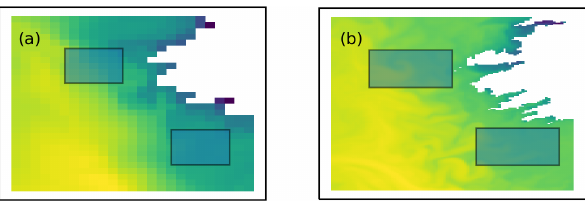
Figure 5. Similar neighbourhood sizes for a 49km neighbourhood using the approximate resolutions (7 and 1.5km) with (a) AMM7 with a 7 × 7 neighbourhood and (b) AMM15 with a 33 × 33 neigh- bourhood. Whilst the neighbourhoods are similar sizes in the lati- tudinal direction, the AMM15 neighbourhood is sampling a much larger area due to different scales in the longitudinal direction. This means that a comparison with a 25 × 25 AMM15 neighbourhood is more